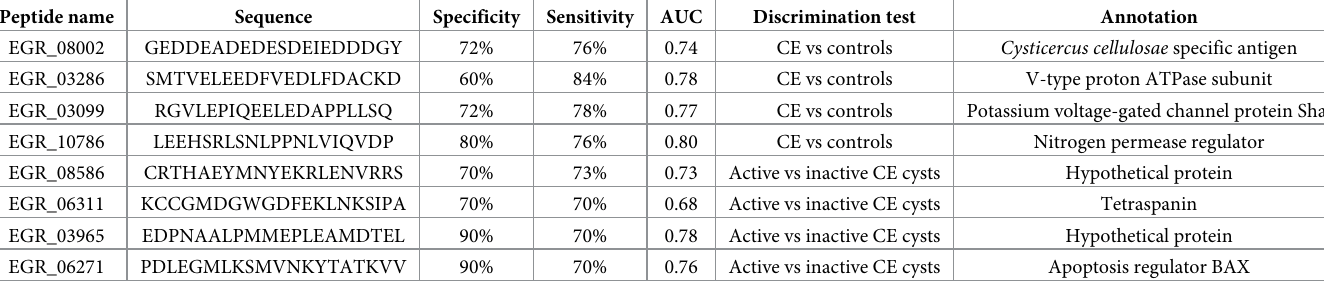
Table 2. Sensitivity and specificity of the candidate antigens identified through peptide microarray.